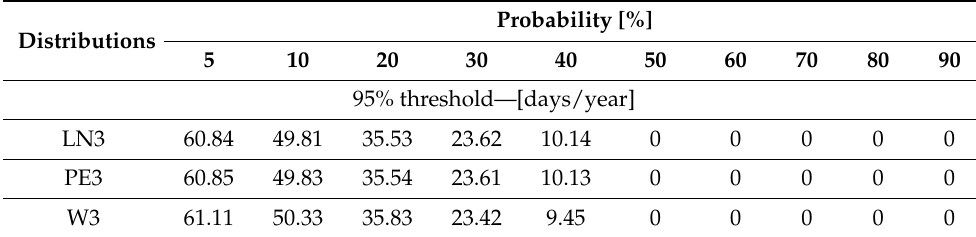
Figure 10. The probability distribution curves for annual deficit volume. Table 11 presents the result values of quantiles for annual drought duration. Table 11. Quantile results for annual drought duration.